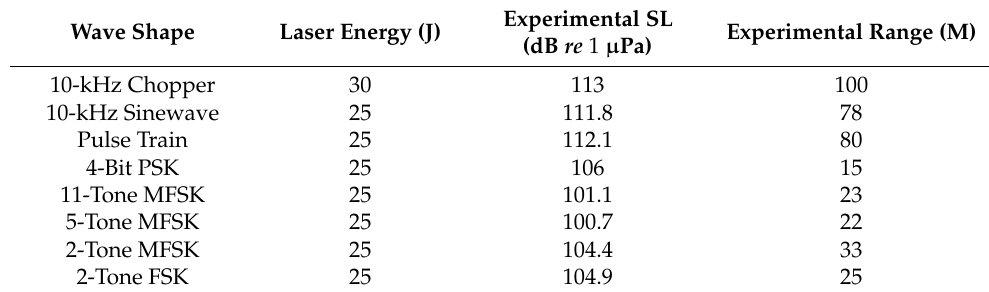
Table 2. Experimental results of range and sound pressure level for different modulation techniques using linear photoacoustic [39].